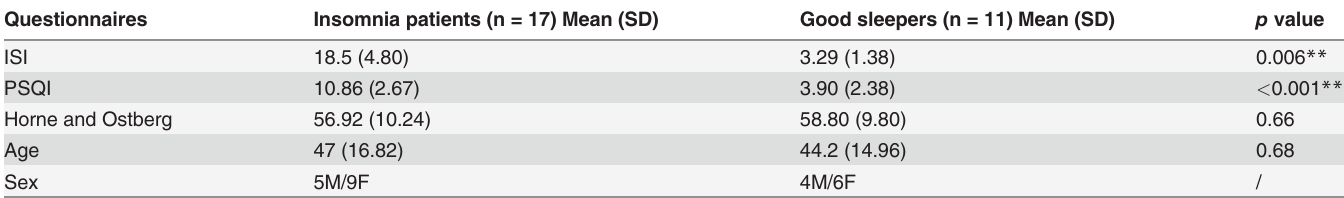
Table 1. Baseline characteristics of